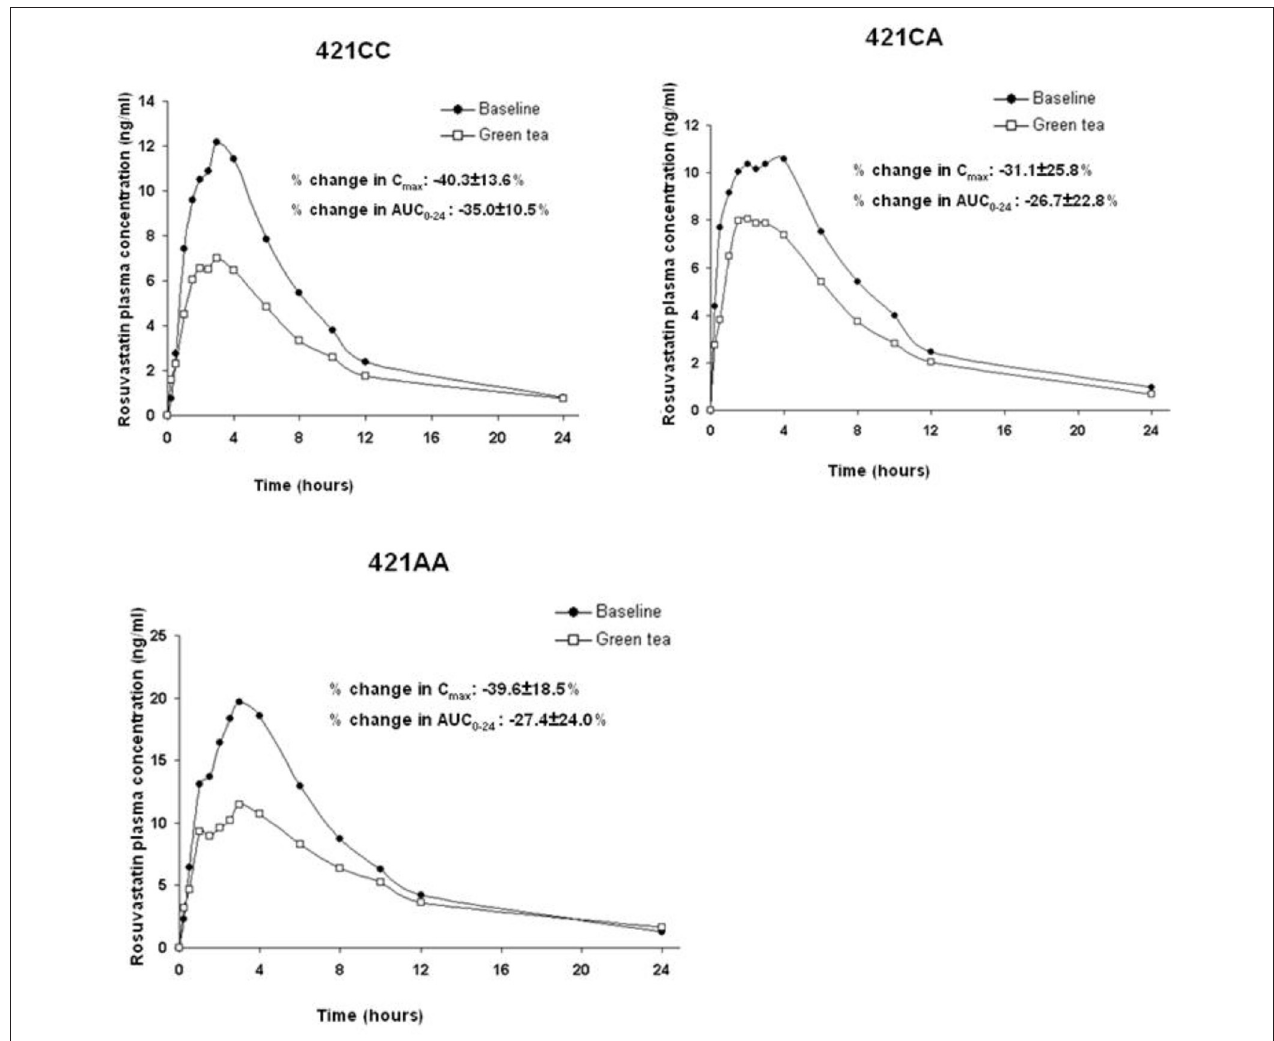
FIGURE 3 | Effect of the ABCG2 421C > A polymorphism on the pharmacokinetic interaction between rosuvastatin and green tea. Data are arithmetic mean.